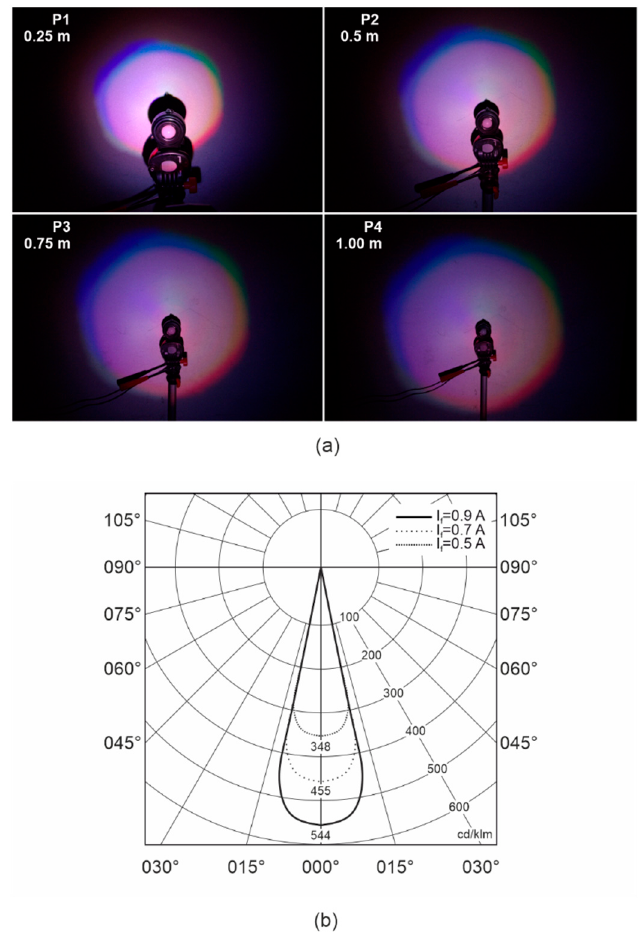
Figure 14. Verification of light intensity depending on the distance: ( a ) total light pattern; ( b ) luminous intensity distribution curve of ASLODE.